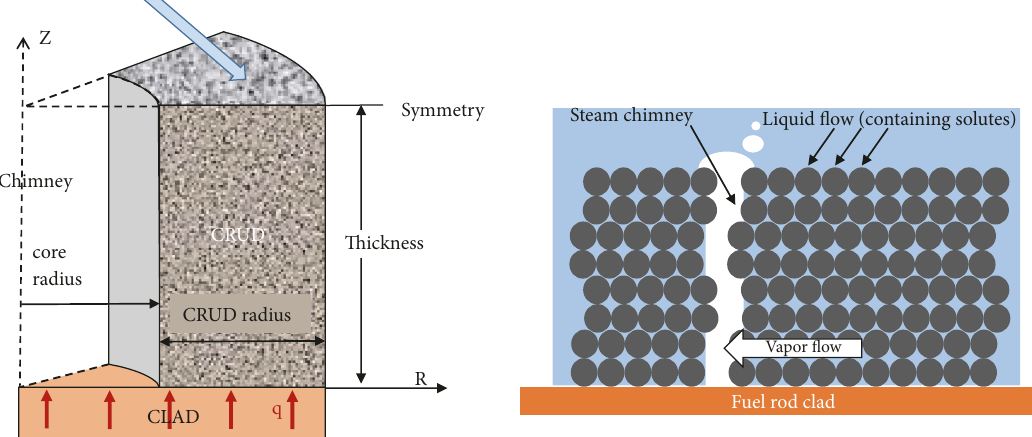
Figure 3: Chimney-centred wick boiling sketmatic (a): a diagram of boundarys; (b) a diagram of heat transfer process.